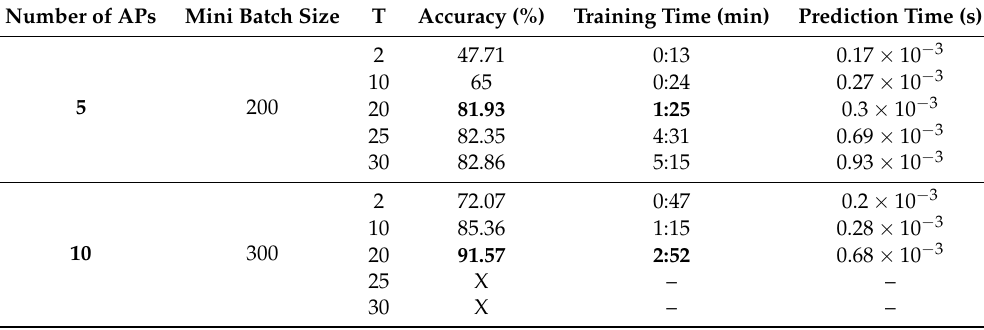
Table 6. Variation of the accuracy according to T using a grid of size 2 m × 2